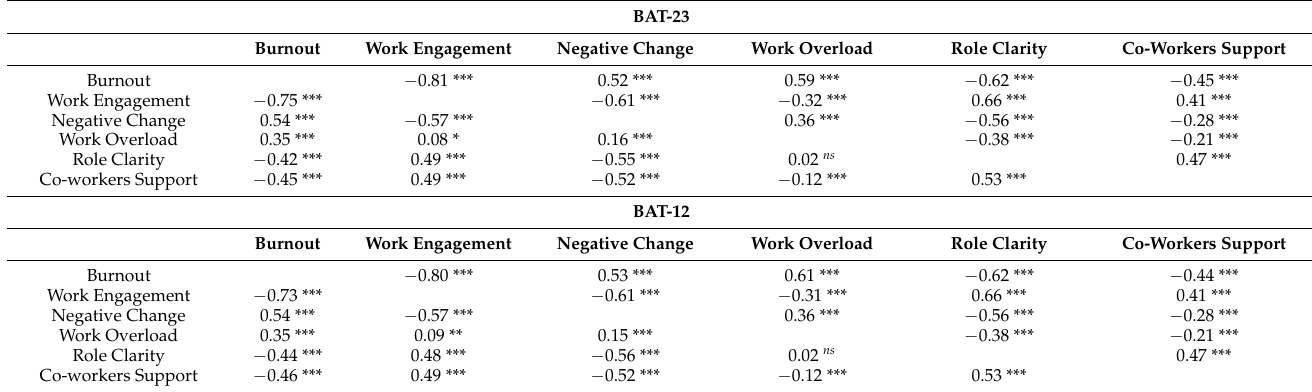
Table 8. Measurement model standardized latent correlations. BAT-23 Burnout Work Engagement Negative Change Work Overload Role Clarity Co-Workers